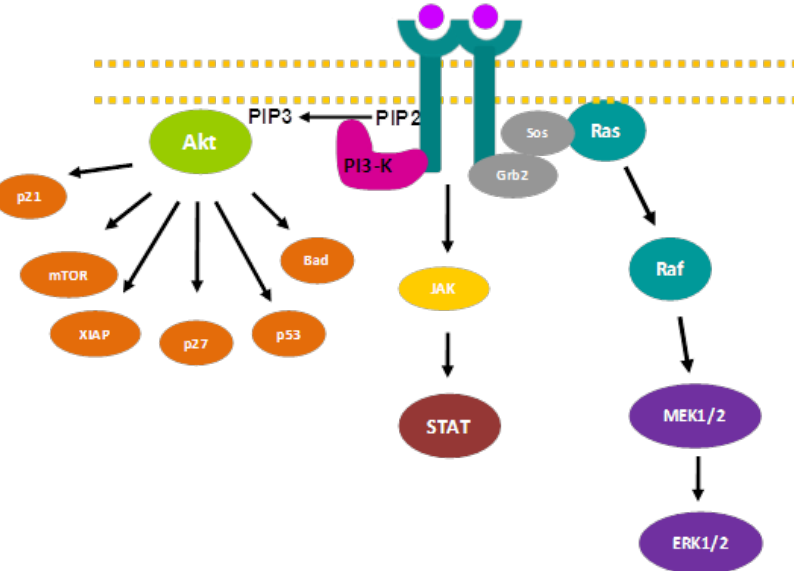
Figure 1. Main signal transduction pathways initiated by